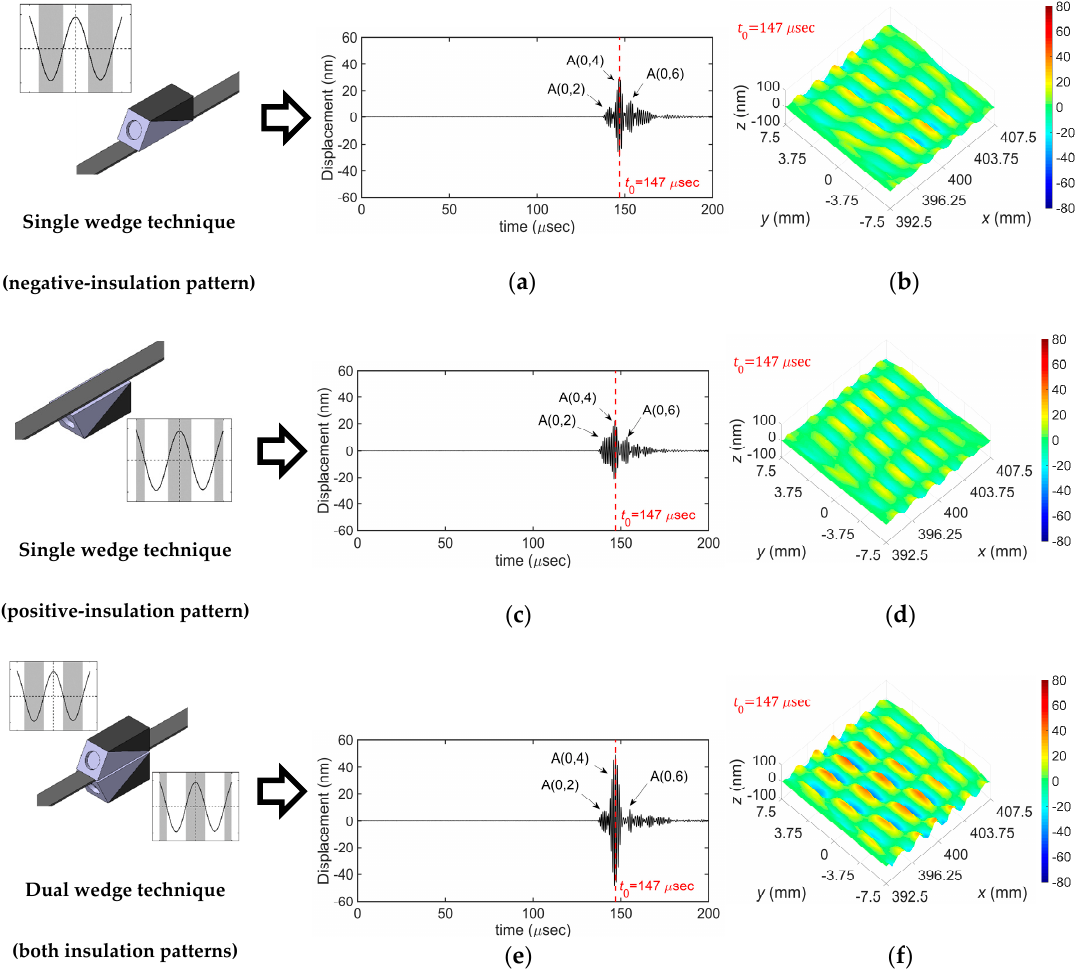
Figure 14. Experimental results for the selective generation of the A(0,4) mode: ( a ) time history and ( b ) displacement distribution obtained by using the single wedge technique with the negative-insulation pattern; ( c ) time history and ( d ) displacement distribution obtained by using the single wedge technique with the positive-insulation pattern; ( e ) time history and ( f ) displacement distribution obtained by using the dual wedge technique with both insulation patterns; time histories were picked up at side edge at 400 mm away from the excitation source. Ω